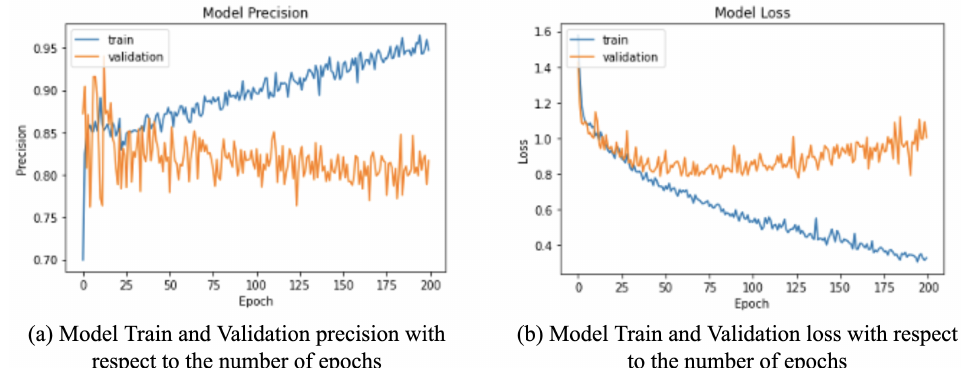
Figure 7. Model precision and loss graphs for the ( a ) training and ( b ) validation sets with respect to the number of epochs. The validation loss of the model started to stabilize around epoch 75 and then began to overfit. Additionally, the precision values of the model also started dipping shortly after epoch 75. Hence, the number of epochs to train the model was chosen to 75.